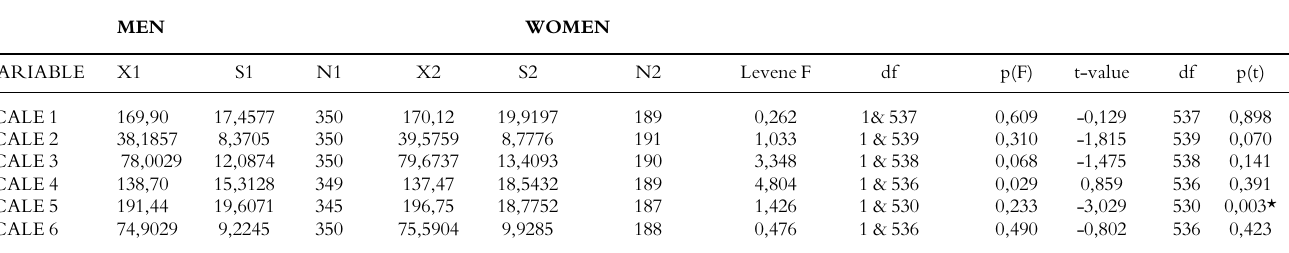
TABLE 8 HOTELLINGT2: COMPARISONOF THE MEANSOF MENANDWOMENIN RESPECTOF THESIXSCALESOF THELSPQ